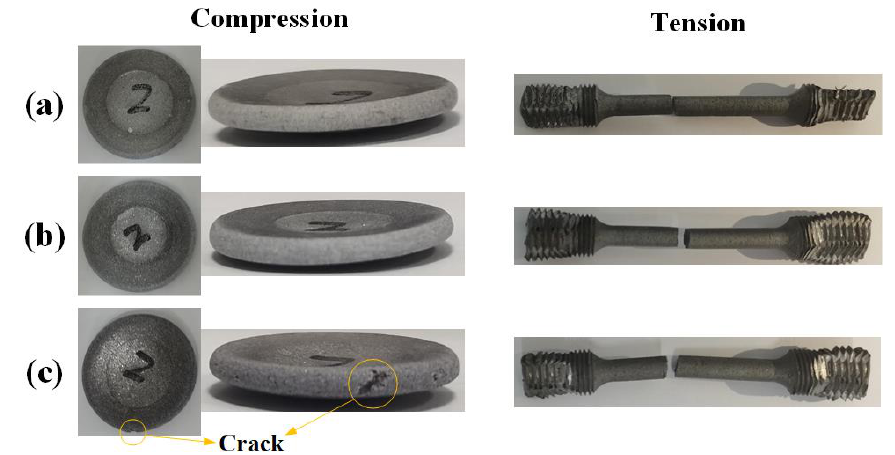
Figure 5. Samples after quasi-static loading. ( a ) M20, ( b ) M50 and ( c ) M80.